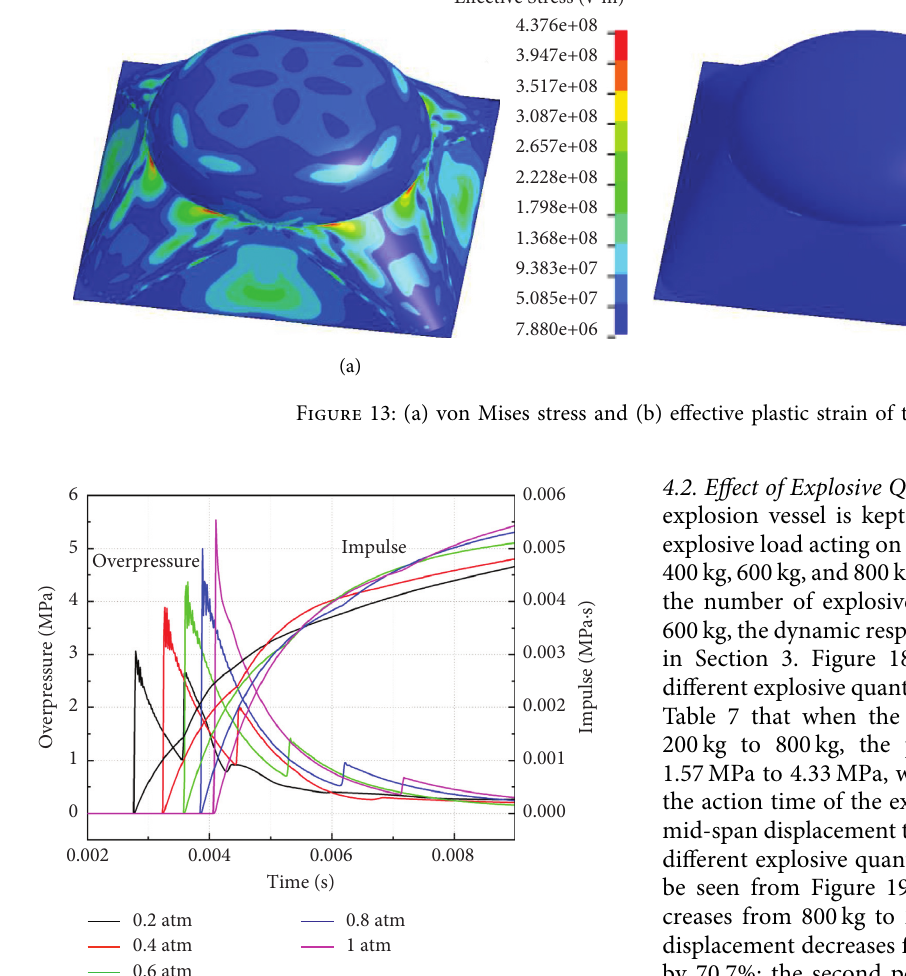
Figure 14: Explosive load under different vacuum